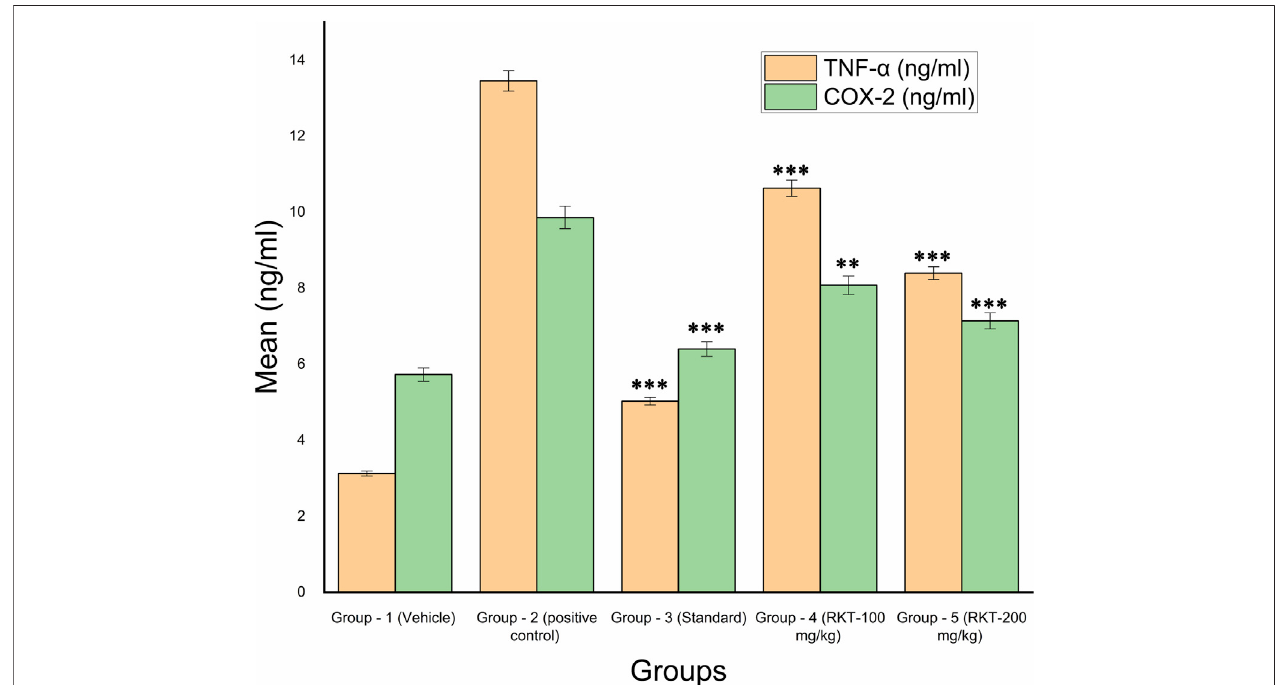
FIGURE 10 | In-vivo TNF- α and COX-2 Estimation. All the values are expressed as Mean ± SEM ( n (cid:2) 6) *** p < 0.001 (G2 vs. G3, G4 and G5) For COX 2: ** p < 0.01 (G2 vs. G4); *** p < 0.001 (G2 Vs G3 and G5).